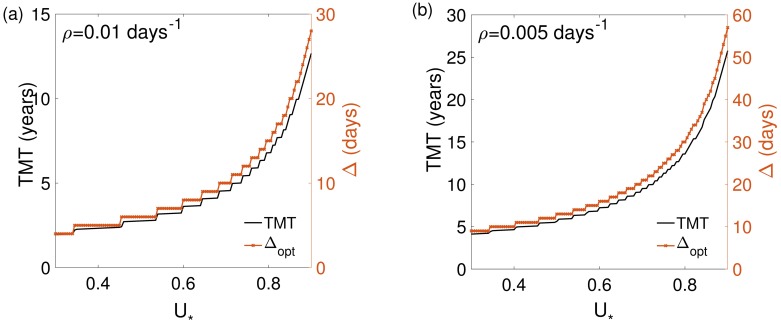
Dependence of the TMT and Δopt on U* for U0 = 0.3.(a) ρ = 0.01 day−1, (b) ρ = 0.005 day−1. In both cases, the optimal fractionation for each parameter set was used.